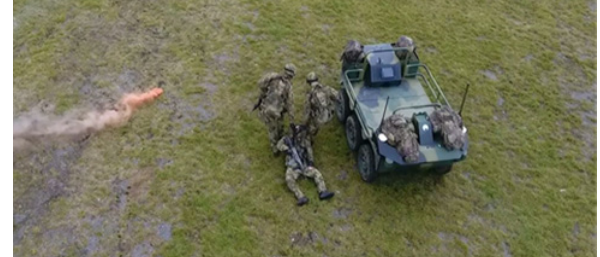
Figure 6 – Usage of the TAROS to cover the wounded team